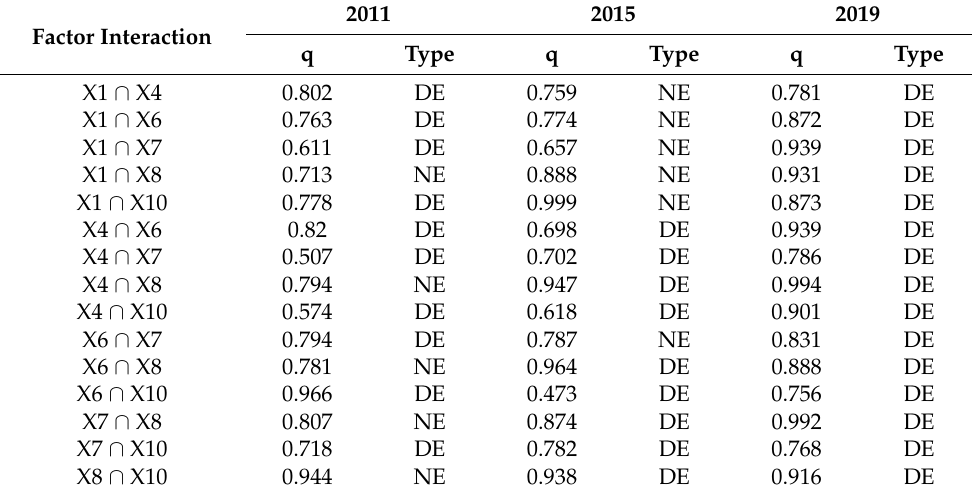
Table 6. Interactive detection results of spatial differentiation of green technology innovation effi- ciency of construction industry. Factor